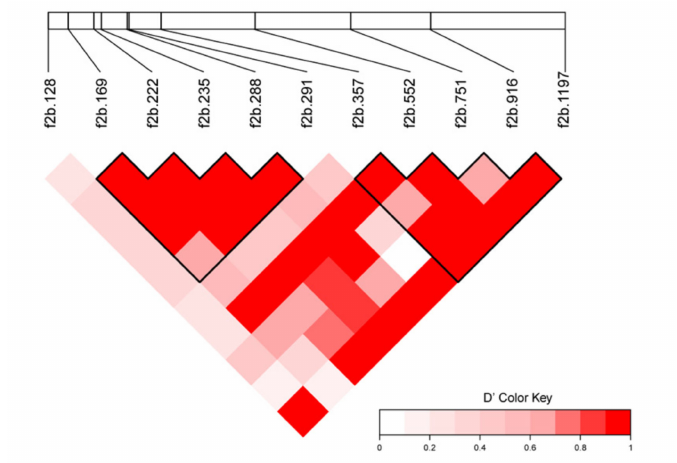
Figure 4. Two haplotype blocks in the fads2b CDS. The red color represented tight